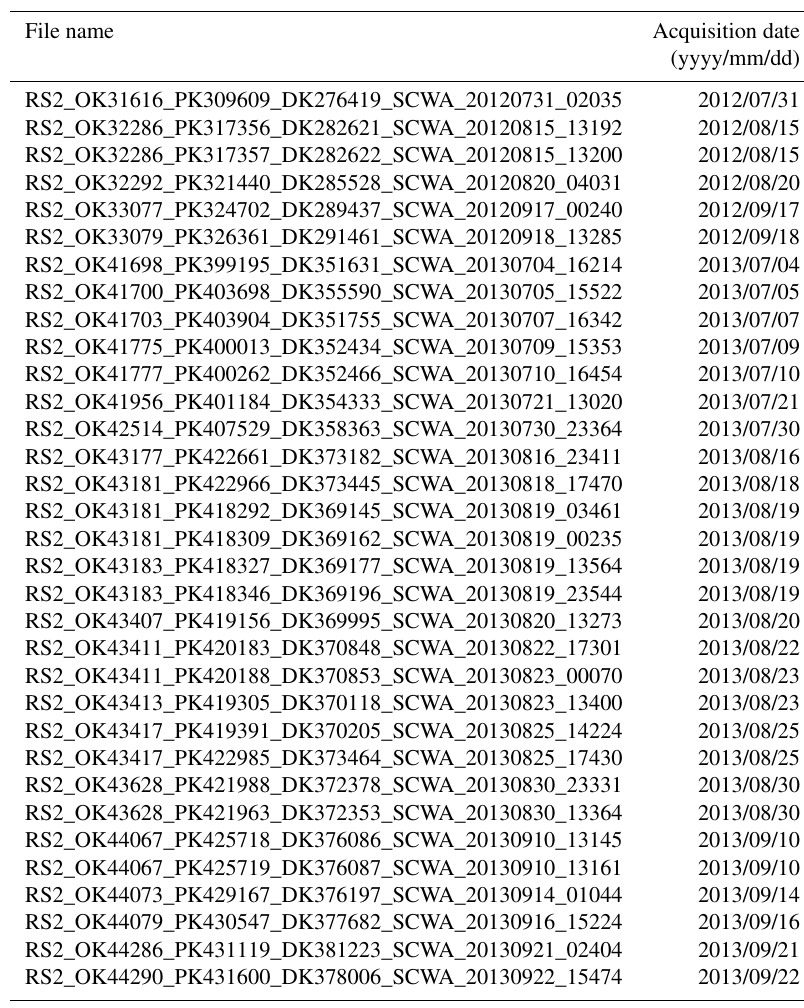
Table A2. Continued table of satellite images used in this study. The first column is the acquisition file name, and the second column contains the date that the image was acquired.